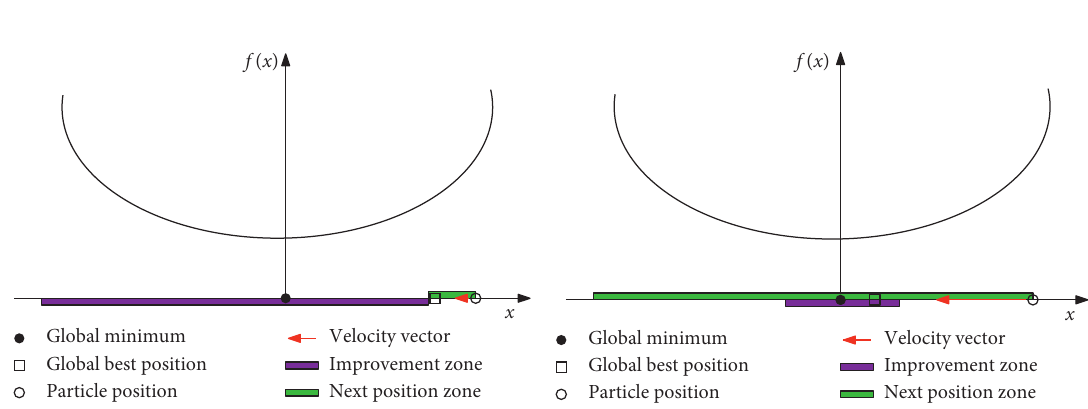
Figure 3: AIWPSO schematic diagram.